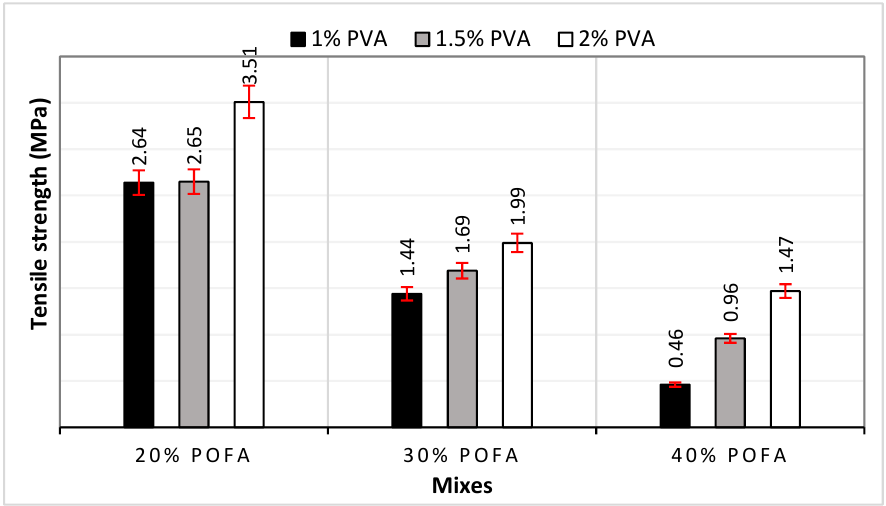
Figure 6. Tensile strength of POFA-ECC mixes.